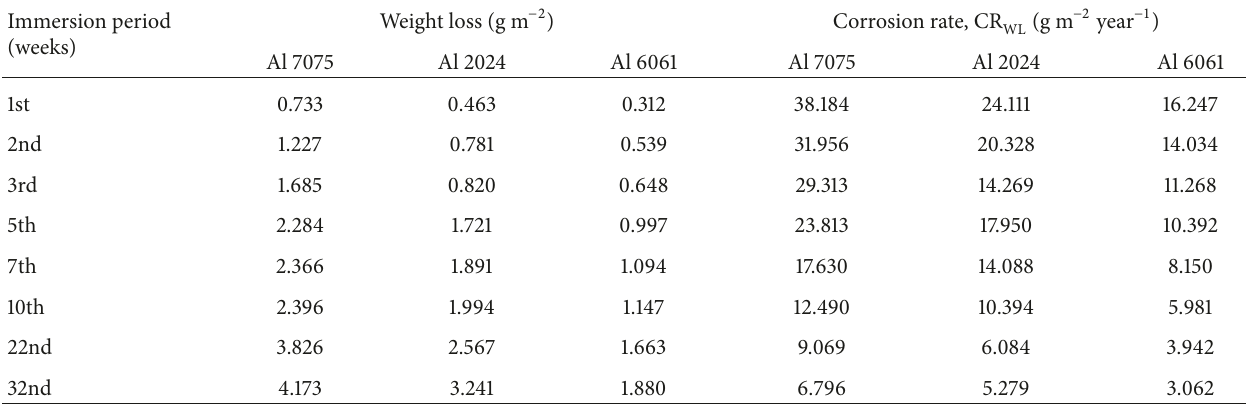
Table 2: Weight loss and corrosion rates of Al alloys at different immersion periods in the Red Sea water. Immersion